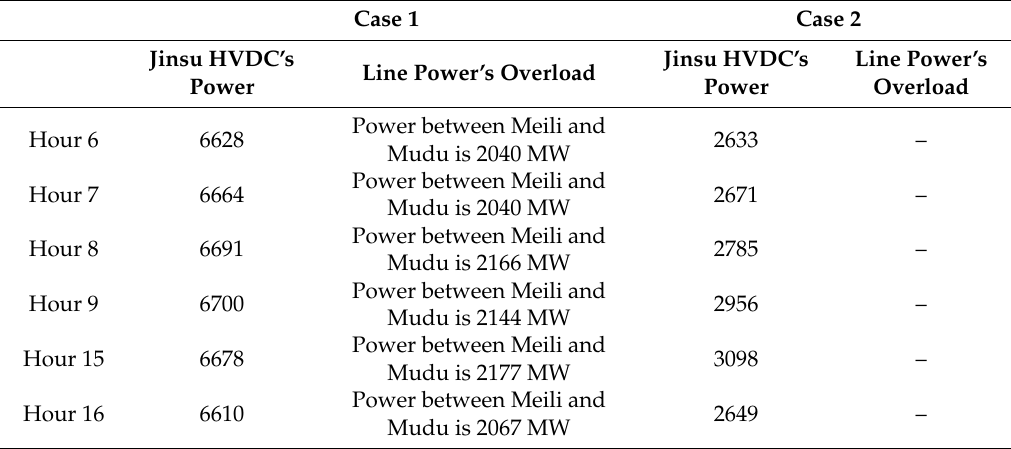
Table 6. Jinsu power and operation of branches after Jinsu block